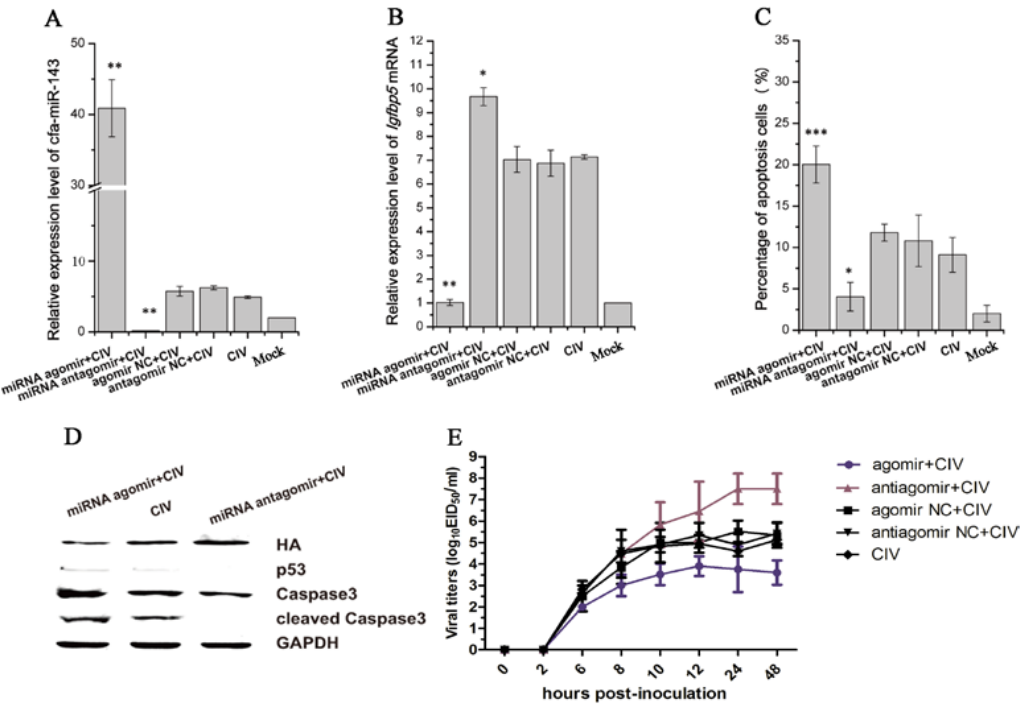
transfection in CIV H3N2-infected cells (Figure 4B). Meanwhile, the miRNA agomir significantly increased the percentage of apoptotic cells (Figure 4C) by activating p53 and caspase3 in CIV-infected cells (Figure 4D). Interesting, virus production decreased with miRNA agomir transfection and increased with miRNA antagomir transfection (Figure 4E).